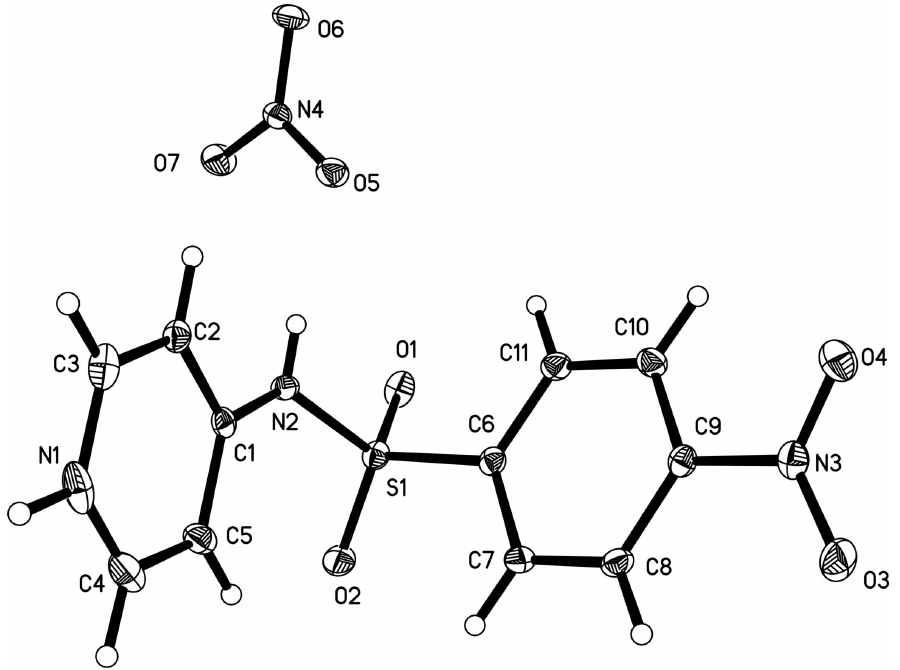
Figure 1 View of one molecule of the title compound showing the atom-labelling scheme. Displacement ellipsoids are drawn at the 35% probability level (arbitrary spheres for the H